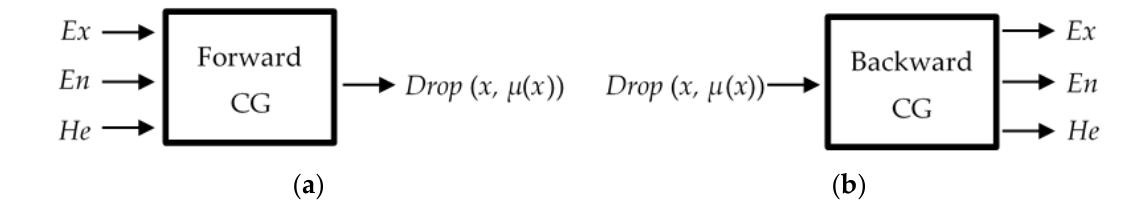
Figure 9. Two different types of cloud generator (CG): ( a ) forward CG and ( b ) backward CG.